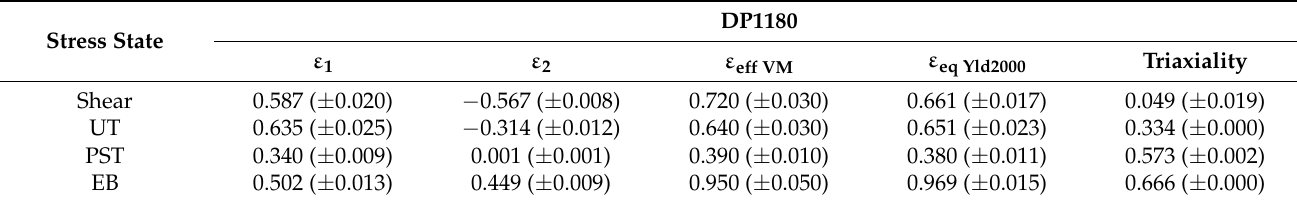
Table A6. Summary of fracture strains for the DP1180 AHSS. Note that the von Mises effective strain corresponds to the absolute strain assuming a linear strain path. The Barlat Yld2000 equivalent strain corresponds to the accumulated work-conjugate equivalent strain integrated along the measured strain path and accounts for material anisotropy.